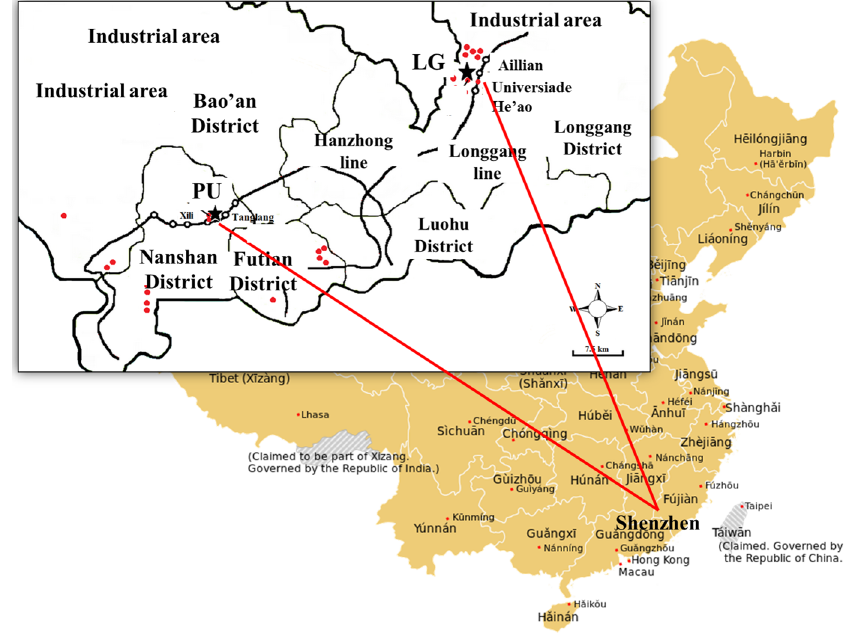
Figure 1. Map showing the geographical location of the PU and LG sampling sites (shown as stars) relative to the Universiade center in Shenzhen. The red dots in the map represent the stadiums where the events were held [28].